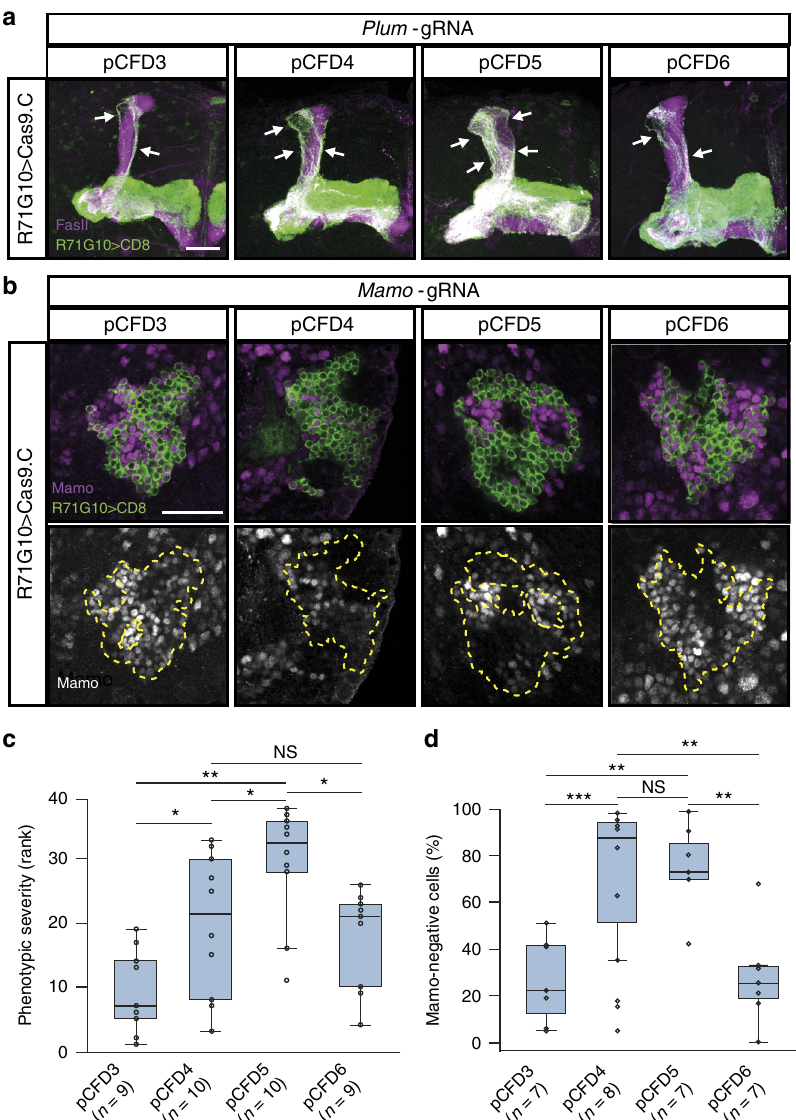
Fig. 2 A thorough comparison of different gRNA-expressing vectors. a Confocal Z-projections of adult MBs expressing Plum -gRNAs using pCFD3/4/5/6, as well as UAS-Cas9.C and CD8 driven by R71G10-GAL4 . b Single-confocal sections of the MB cell body region 6 h after puparium formation